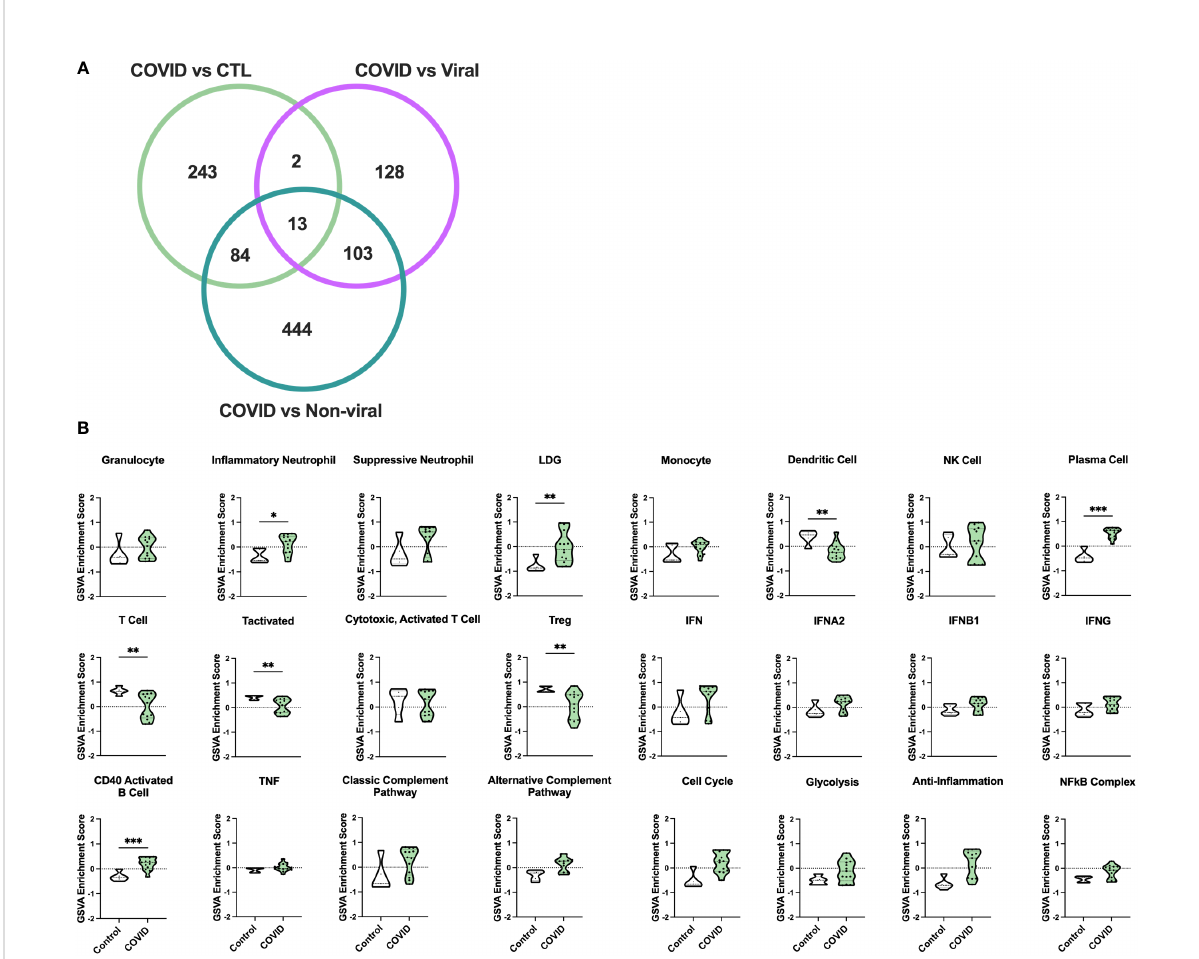
FIGURE 1 Gene signature analysis differentiates COVID-19 AHRF patients and control ICU patients. (A) Venn diagram of differentially expressed genes between COVID-19 patients and other ICU cohorts. (B) Individual sample gene expression from COVID-19 and control ICU patients was analyzed by GSVA for enrichment of immune cell and pathway gene signatures. Enrichment scores are shown as violin plots. *p < 0.05, **p < 0.01, ***p <